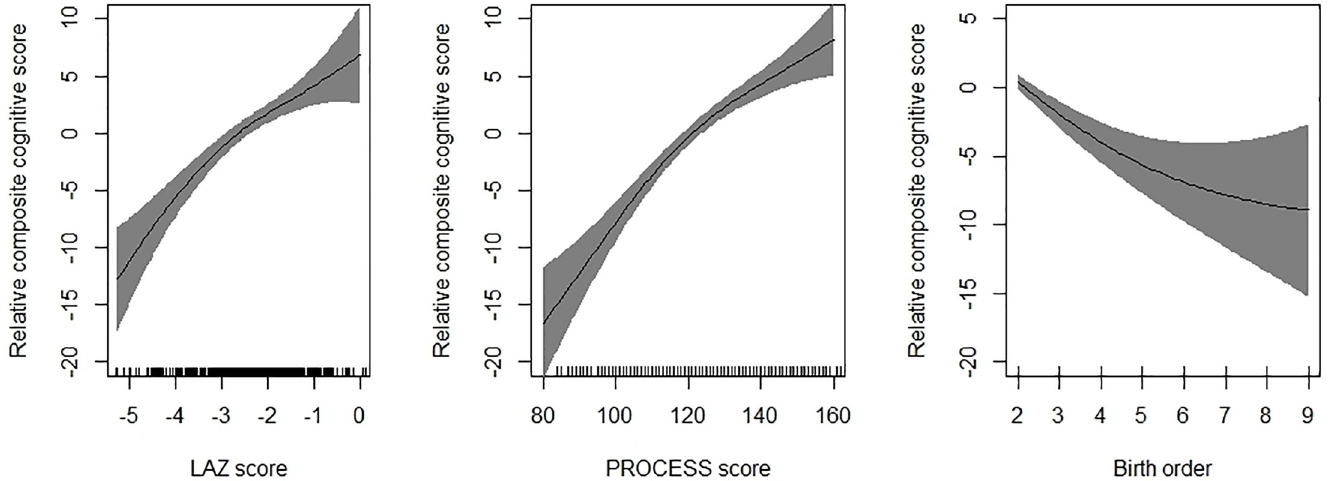
Fig 1. Association between length for age z-scores (LAZ); PROCESS score and birth order with change in composite cognitive score. The graphs were constructed using generalized additive models in R, the solid line depicts the association of composite cognitive score and HAZ/PROCESS score/birth order. The Y-axis is centered on the mean composite cognitive score. The shaded area spans the 95% confidence interval of this association.